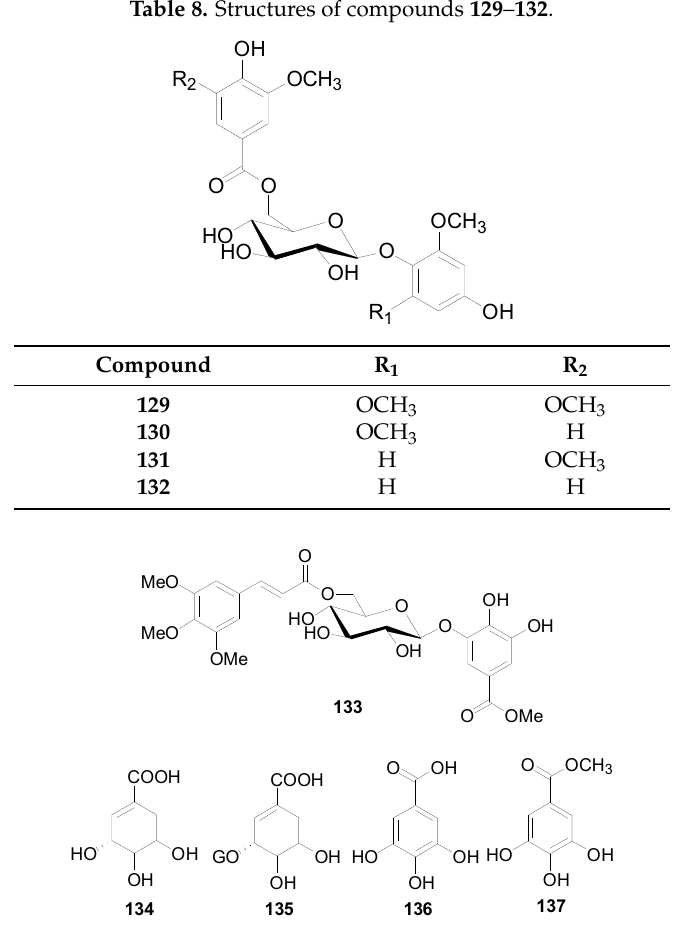
Figure 7. Structures of compounds 133 – 137 .